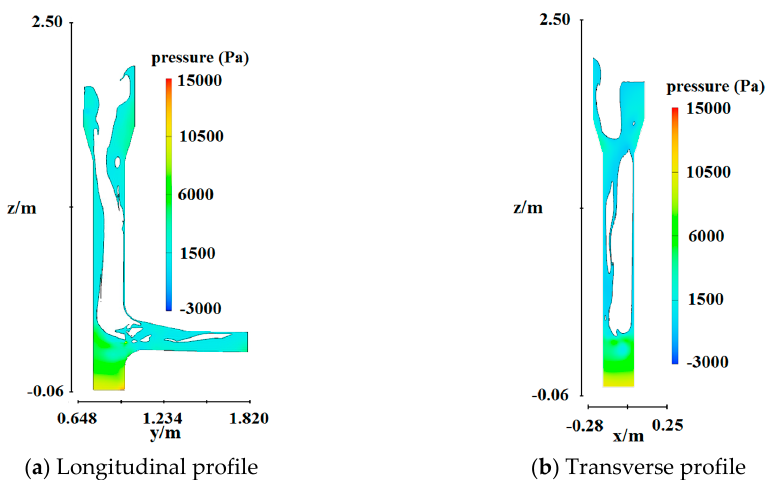
Figure 13. Pressure profiles based on the numerical simulations (P = 0.1%).